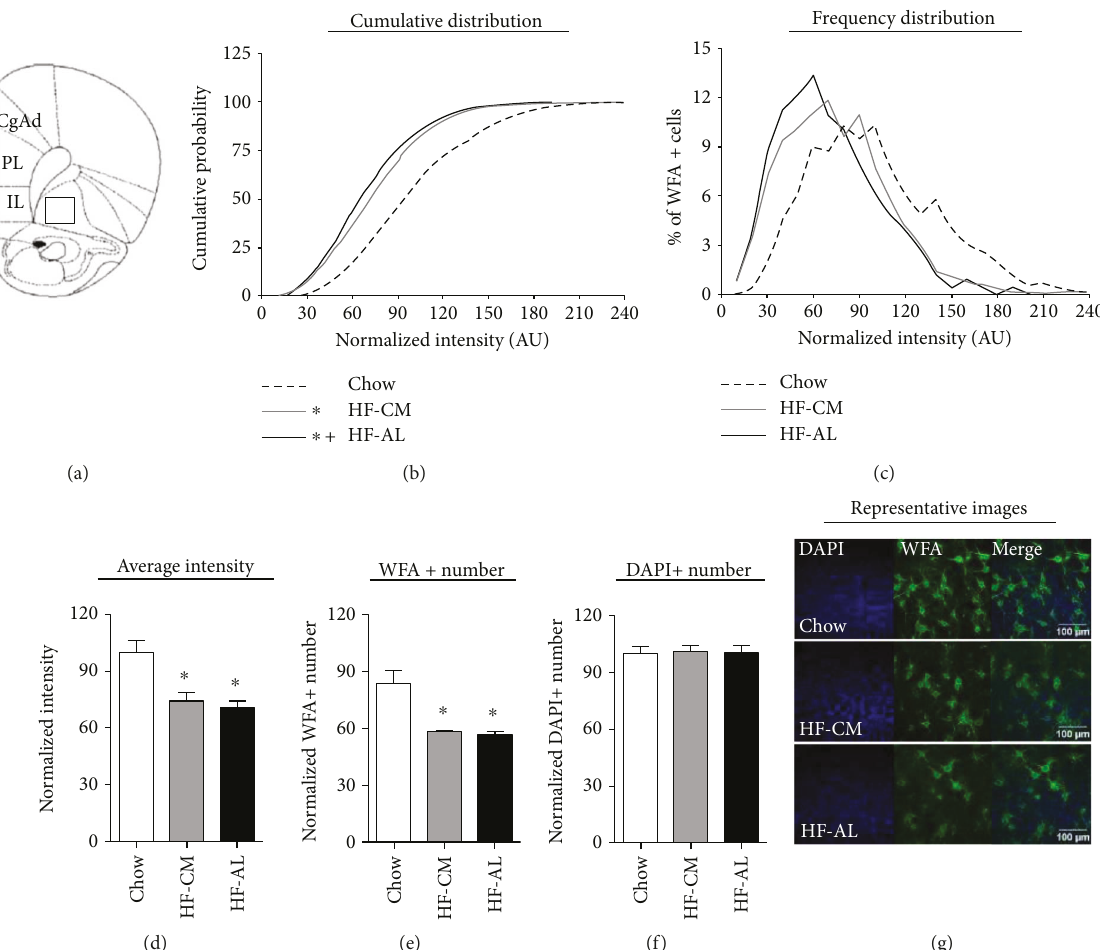
Figure 4: Consumption of a high-fat diet attenuates PNN intensity and number, in the orbitofrontal cortex (OFC). (a) Schematic of the region analyzed. (b) Normalized PNN intensity expressed as a cumulative probability for chow (dashed line), HF-CM (gray line), and HF- AL (black line) groups. (c) Normalized PNN intensity expressed as a frequency distribution for chow, HF-CM, and HF-AL groups. (d) Normalized average PNN intensity among chow (white), HF-CM (gray), and HF-AL (black) groups. (e) PNN number, measured by the number of WFA+ cells. (f) Cell density, measured by the number of DAPI+ cells. (g) Representative images shown as max projections of z-stacks. Values represent the mean ± SEM ( ∗ / + p < 0 05 ). ∗ indicates signi fi cant di ff erence between HF-CM and chow as well as between HF-AL and chow. + indicates signi fi cant di ff erence between HF-AL and HF-CM